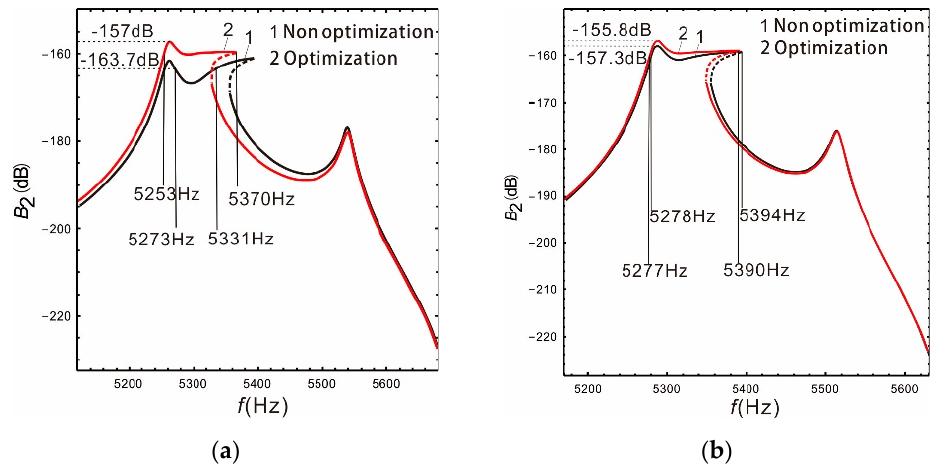
Figure 7. Optimization of bandwidth and gain: ( a ) ∆ = 280 Hz ; ( b ) ∆ = 230 Hz .